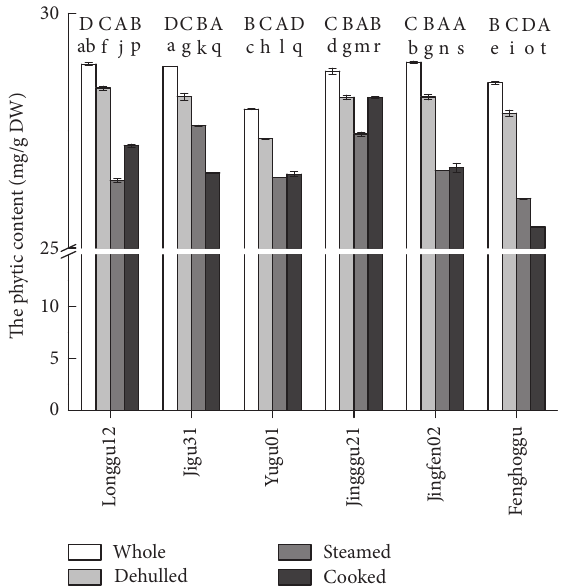
Figure 4: Phytic acid contents of 6 cultivars of foxtail millet with different treatment. Error bars represent the standard deviation ( ± SD). The different uppercase letters (A–D) indicate significant differences within different processing methods of the same cultivar ( 𝑃 < 0.05 ). The different lowercase letters (a–t) indicate significant differences within different cultivars with the same treatment ( 𝑃 < 0.05